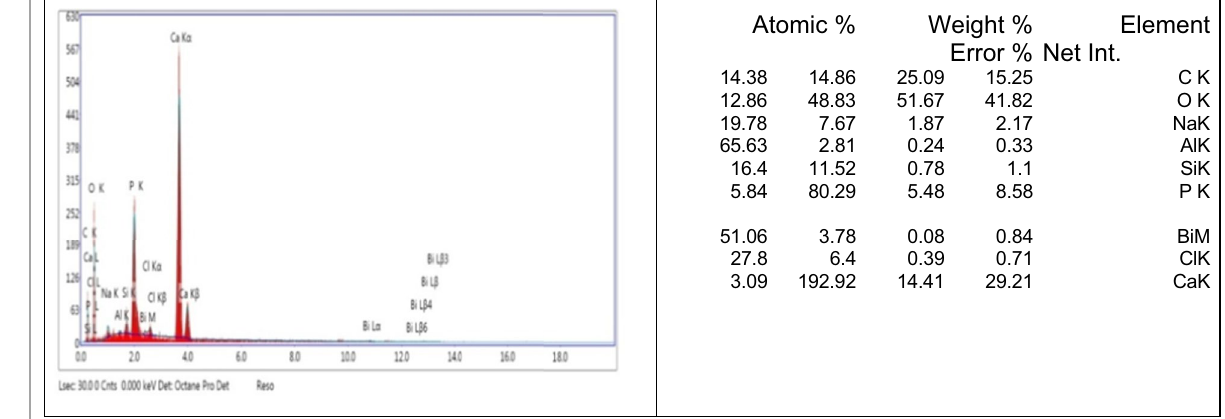
Fig. 12 EDAX analysis of 14-day sample cured in Streptococcus thermophilus bacteria in nutrient broth NB media